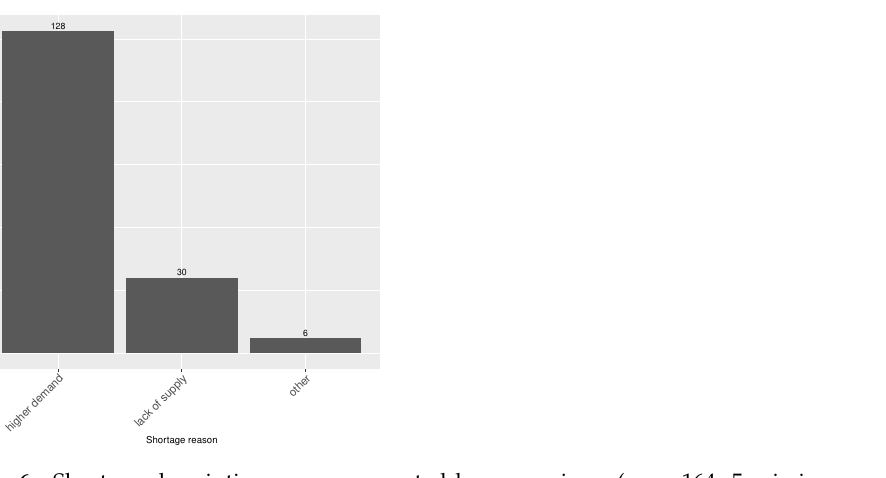
Figure 6. Shortage description reasons reported by supervisors ( n = 164, 5 missing answers, 2 responses not reporting shortage).